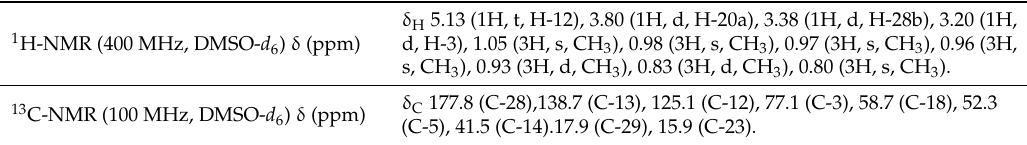
Table 2. Spectroscopic constants of uvaol.